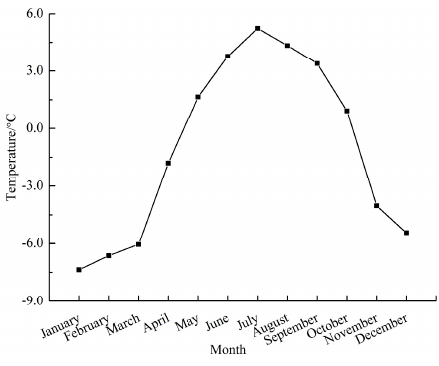
Figure 2. Monthly mean temperature from October 2008 to September 2009 at 4800 m on Baishui Glacier No. 1.